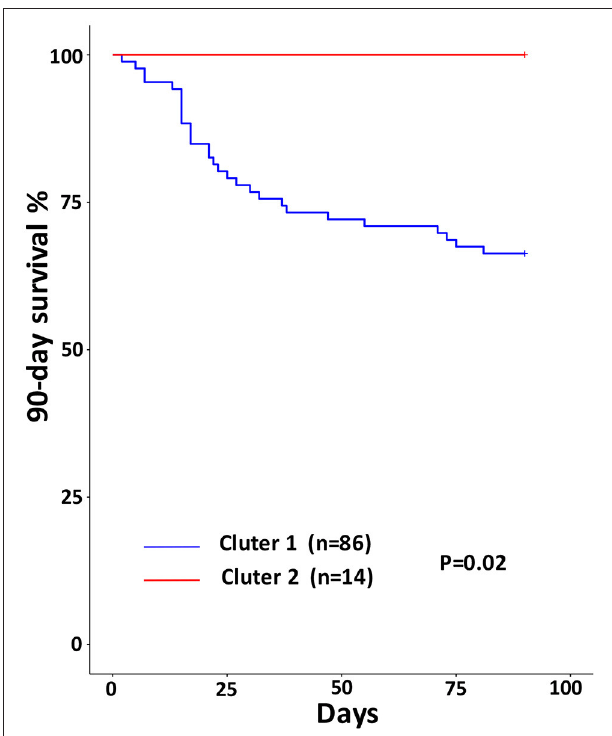
FIGURE 5 | Ninety-days Kaplan–Meier survival curves for different ascitic microbiota clusters. P -values were calculated by the Log Rank-test.